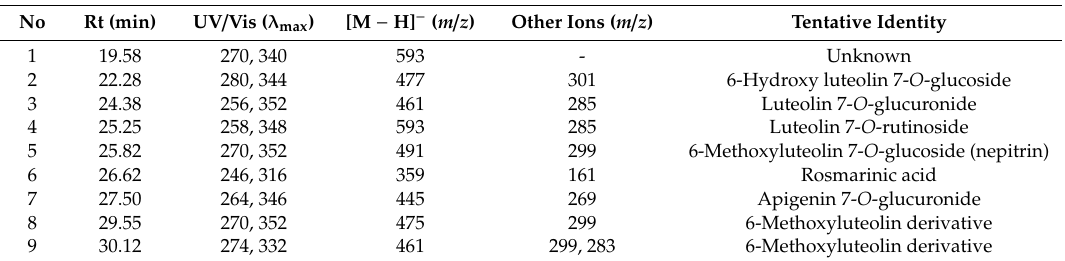
Table 9. Spectral information pertaining to polyphenols detected in S. fruticosa extracts, obtained with either CD